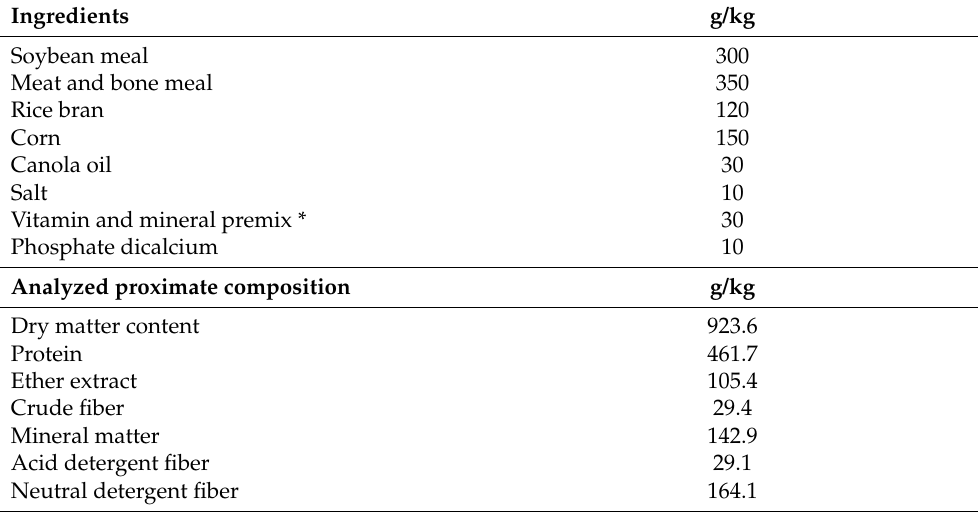
Table 1. Formulation of the experimental